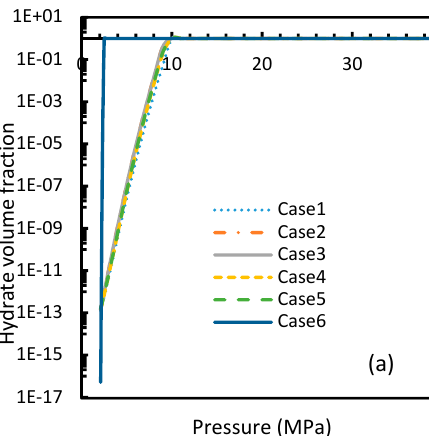
Figure 21. Profiles of hydrate volume fractions at theoretical induction time of CO 2 ( a ) and CH 4 ( b ) under isothermal conditions with the reference temperature of 273.2 K, calculated through the considered cases, apart from Case 6, from Case 2. It can be seen that at sufficient pressures, the hydrate formation becomes rapid enough to instantaneously shift to 100% conversion by the time of theoretical induction time. Additionally, a profound willingness of CO 2 hydrate formation can be seen in the profile case 6.